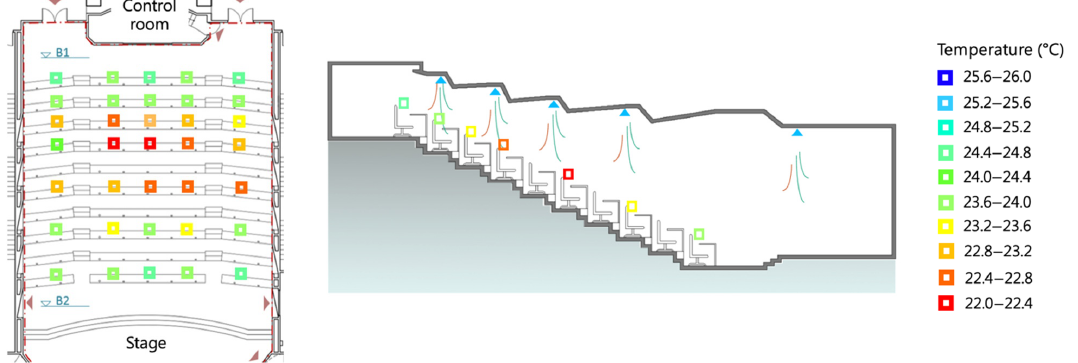
Figure 12. Temperature distribution measurement results: plan and profile of the case room.